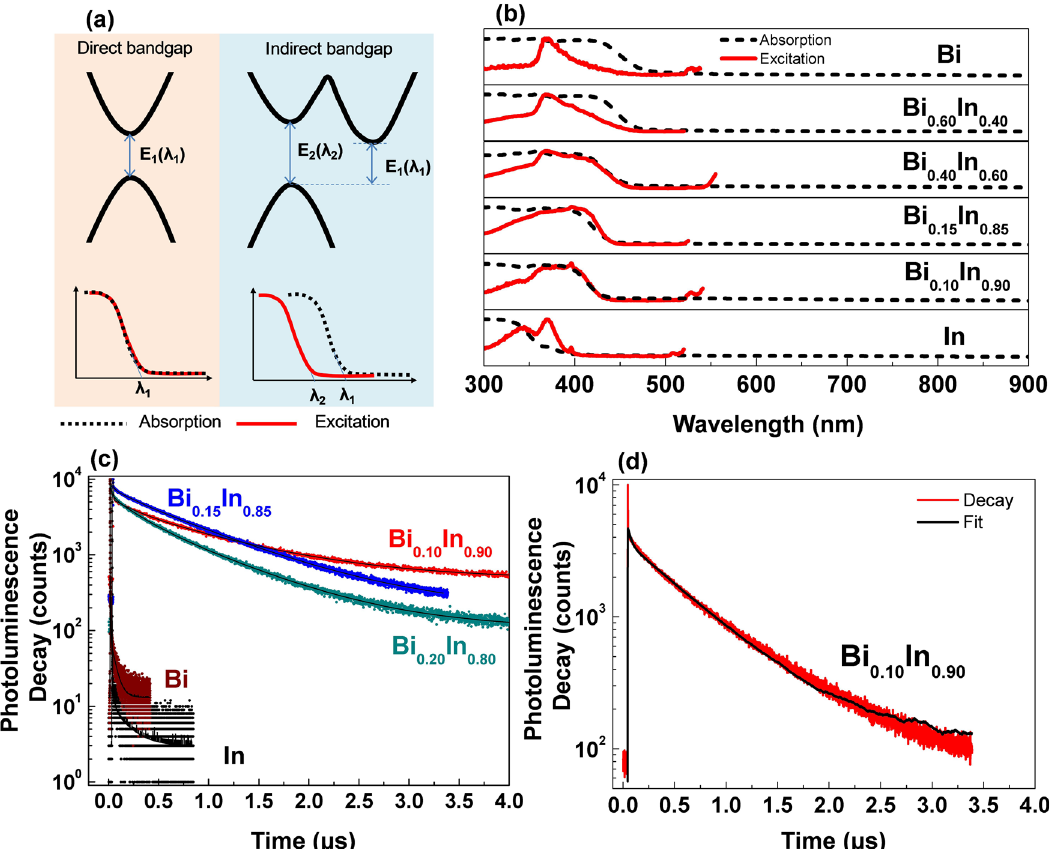
Fig. 5 Excitation and time-resolved photoluminescence properties of halide double perovskites. a Schematic representation of direct and indirect bandgap semiconductor materials and their expected absorption and excitation spectra. b Normalized absorption and excitation spectra of selected Cs 2 AgIn x Bi 1 − x Cl 6 compounds, where the dotted black line represents the absorption spectra and the solid red line represents the excitation spectra. Excitation spectra were measured by monitoring the emission wavelength at 575 nm. c Time-resolved single-photon counting (TRSPC) measurements for CABC, Bi 0.20 In 0.80 , Bi 0.15 In 0.85 , Bi 0.10 In 0.90, and CAIC compounds. TRSPC measurements were carried out by exciting the samples at a pulsed-laser wavelength of 402 nm and monitored at an emission wavelength of 500 nm (solid circles represent the photoluminescence decay and the solid black line represents the fi tted components). d Time-resolved photoluminescence spectrum of single-crystal Bi 0.10 In 0.90 sample at emission wavelength 500